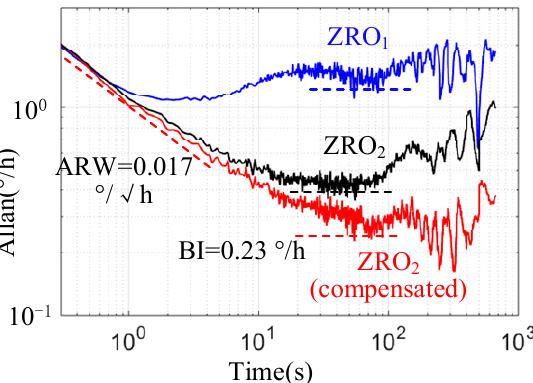
Figure 12. Online compensation process for